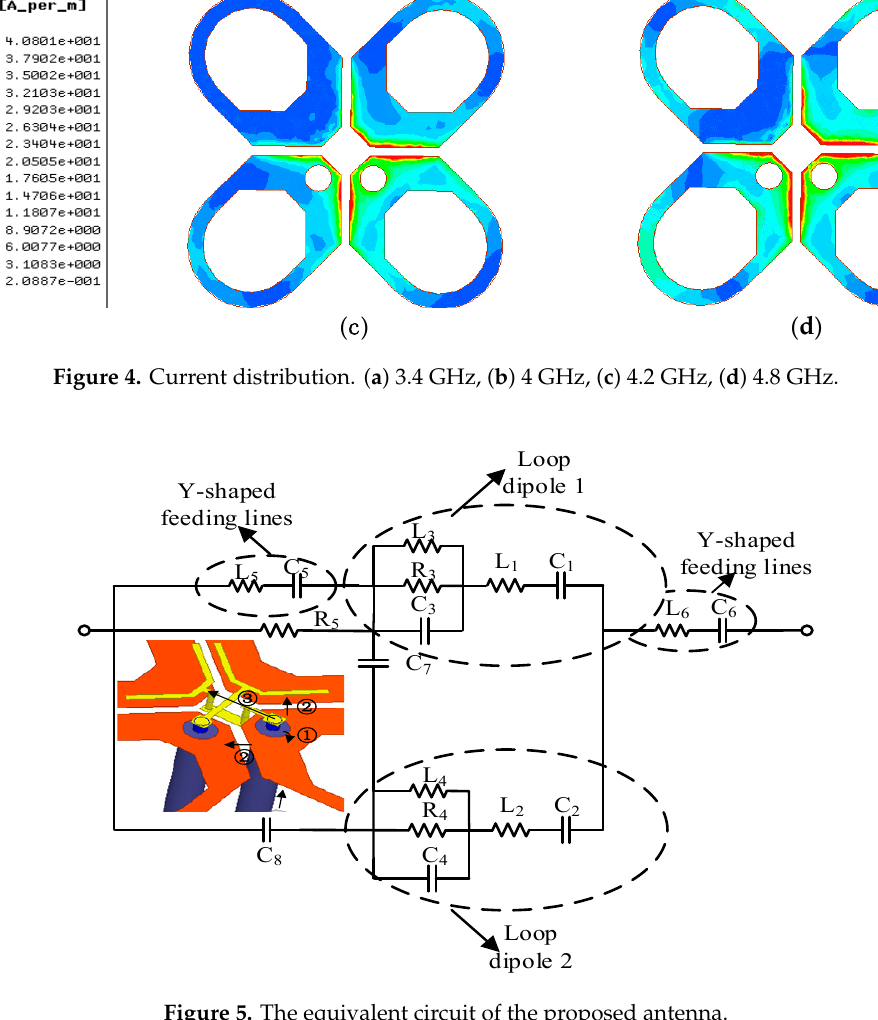
Figure 6. Comparison of simulation results between HFSS and ADS. ( a ) HFSS, ( b ) ADS. 4. Parametric Analysis 4.1. Y-Shaped Feeding Lines The variation of S 11 with part of Y-shaped feeding lines parameters is listed in Figure 7. As shown in Figure 7a, by changing the length of Y-shaped feeding lines ( L 6 ), the bandwidth changes significantly, meaning that the coupling strength can be optimized by changing the length of L 6 . As L 6 decreases, the bandwidth gets wider, but the impedance matching gets worse. In addition, the value of H 4 also has a great influence on the coupling strength, which in turn affects the bandwidth. As seen from Figure 7b, the wider bandwidth can be obtained by appropriately reducing the value of H 4 , but the impedance matching will also deteriorate accordingly. Therefore, properly control the coupling strength so that bandwidth and good impedance matching can be achieved (when L 6 = 4.7 mm, H 4 = 1.6 mm). 4.2. Trepanning Analysis Since nuts and plastic columns are introduced to ensure the profile, four holes are considered in the substrate, which shown in Figure 1b. Therefore, it is necessary to choose the suitable position of the holes. Figure 8 illustrates the simulated S-parameters for two cases of trepanning on FR4 substrate. In case 1, the holes are considered at ±45° of the substrate, while the holes are considered at the 0° and 90° of the substrate in case 2. As can be seen from Figure 8a,b, it is similar to S 11 and S 22 , but S 21 is lower than that in case 2. Therefore, case 2 is introduced to the proposed antenna. In addition, due to the limitation of the size of the plastic column, the radius of holes is determined